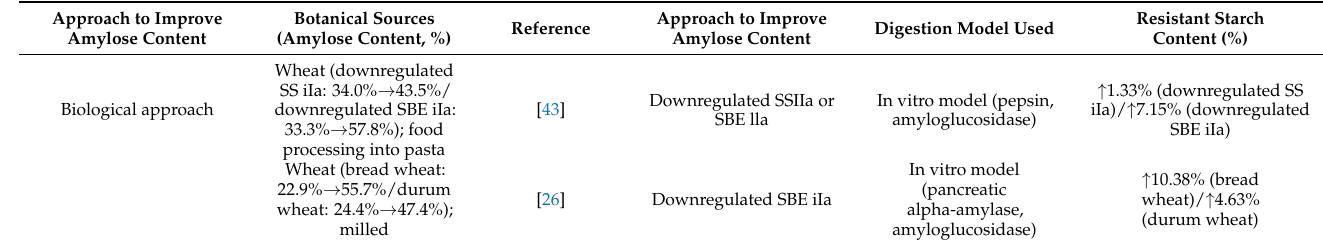
Table 1. Resistant starch content of native and modified high-amylose starches. Approach to Improve Amylose Content Biological